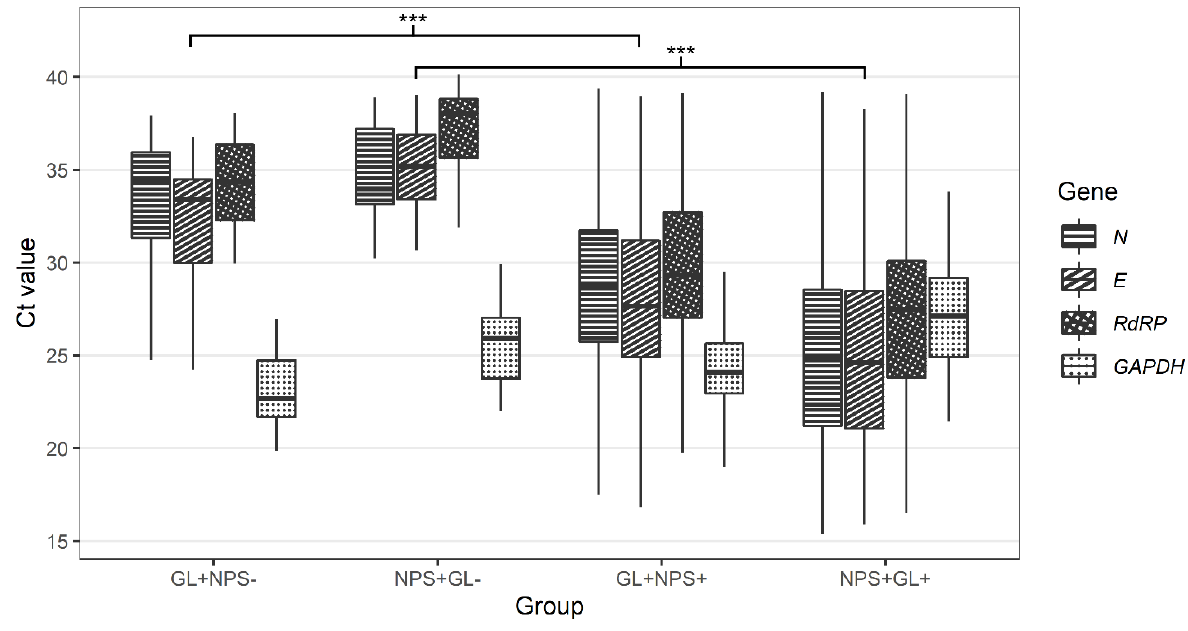
Figure 3. Comparison of Ct values for N , E , RdRP, and GAPDH genes in nasopharyngeal and gargle lavage samples with concordant and discordant results (GL+NPS − - — Ct values for gargle lavage samples for cases found positive only with gargle lavage samples; NPS+GL − -Ct values for nasopharyngeal swabs for cases found positive only with nasopharyngeal swabs; GL+NPS+-Ct values for gargle lavage samples for cases found positive with both gargle and nasopharyngeal swabs; NPS+GL+-Ct values for nasopharyngeal swabs for cases found positive with both gargle and nasopharyngeal swabs; E gene- E gene of SARS-CoV-2; N gene- N gene of SARS-CoV-2; RdRP -gene for RNA-dependent RNA polymerase of SARS-CoV-2; GAPDH -gene for human glyceraldehyde-3- phosphate dehydrogenase (internal control). Calculated by Wilcoxon two-sample test (GL+NPS+ vs. GL+NPS-, NPS+GL+ vs. NPS+GL-) with Bonferroni correction (across genes). *** p < 0.001.